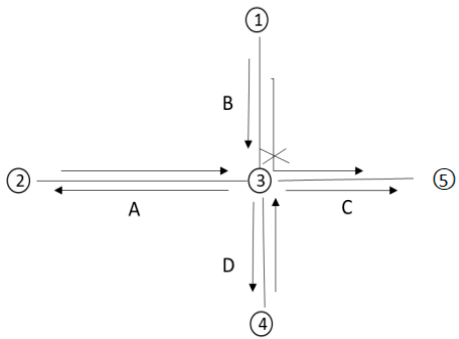
Figure 14. An example of a road network model based on node-edge representation.